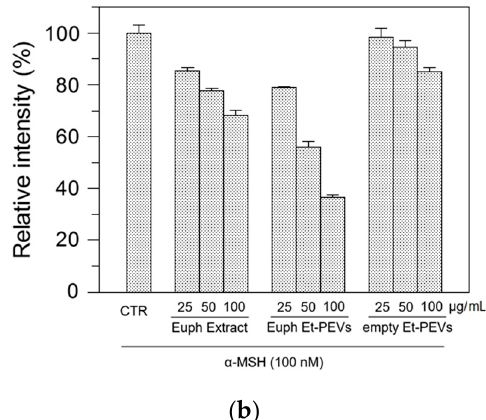
Figure 3. Tyrosinase zymography. ( a ) Effect of E. characias extract, in ethanol solution or in Et-PEVs, and empty Et-PEVs on cellular tyrosinase activity estimated by L-DOPA staining; ( b ) relative intensity of bands determined with ImageJ software. Empty Et-PEVs at the concentration of 25 μ g/mL are not statistically different from the CTR, while different at 50 μ g/mL ( p -value = 0.02). All the other samples are statistically different from each other at equal concentration and from CTR with p -value < 0.01.